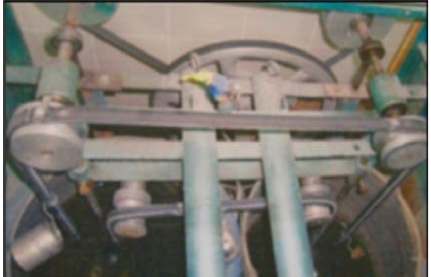
Figure 9: Specimens inside the thermal cycling